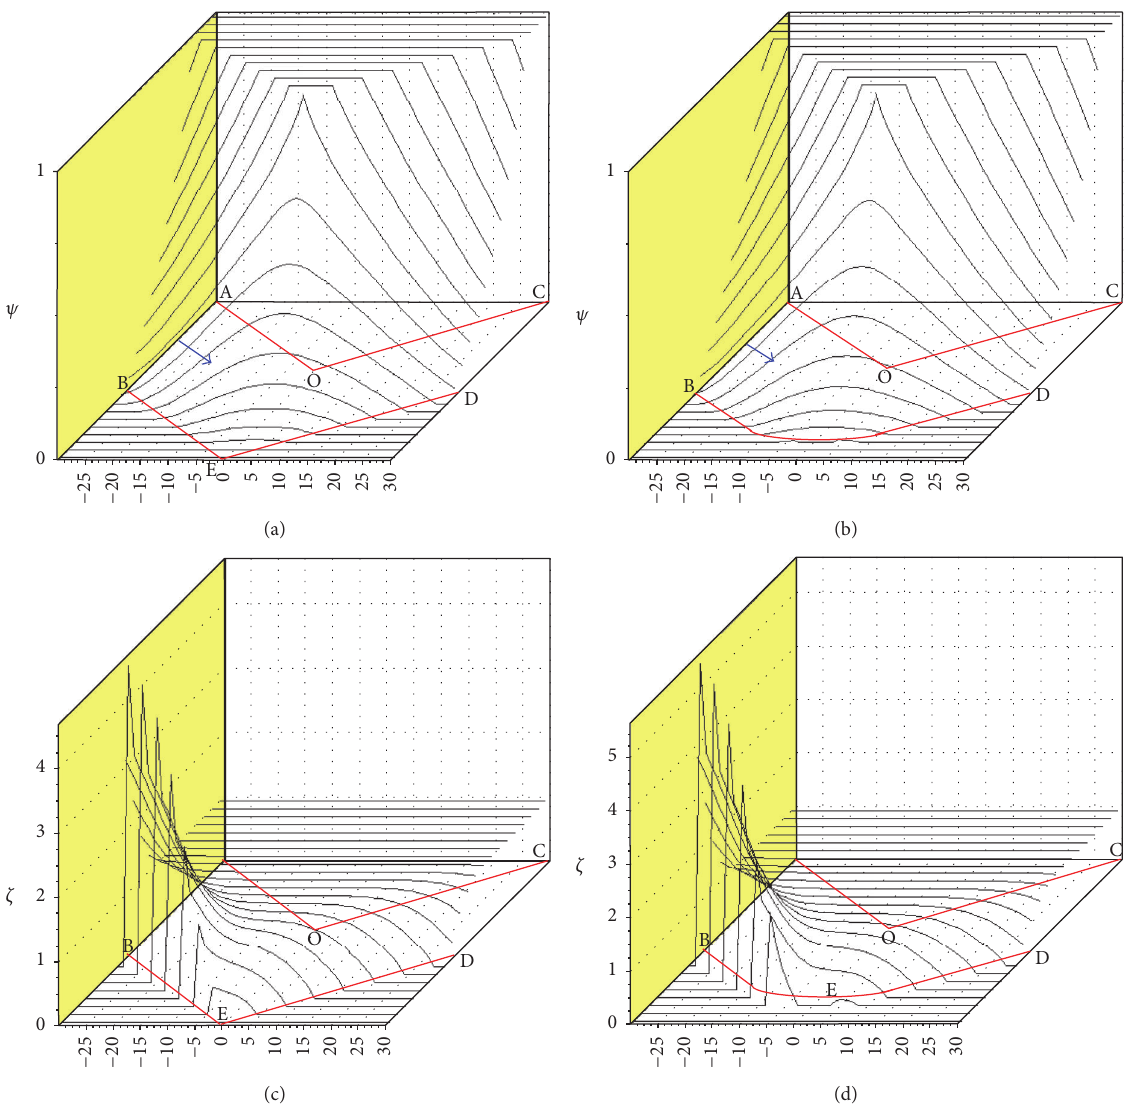
Figure 6: Computational diagrams for the dimensionless flow function 𝜓 (a, b) and for the dimensionless curl function 𝜁 (c, d) for the viscous flow of a plasticine workpiece model through obtuse-angled equal channel angular dies AOC–BED of Segal (a, c) and Iwahashi geometries (b, d) with channel intersection angles ∠ (AOC) = 2 𝜃 = 105 ∘ and external rounding BED in channel intersection zones 𝑅 = 15mm (b, d), where the inlet AB is at the left and the outlet CD is at the